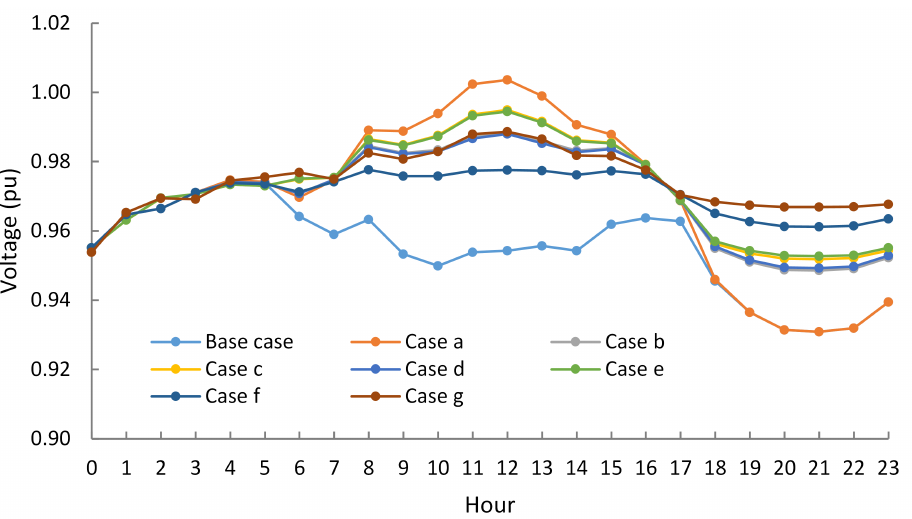
Figure 5. Voltage profile average for all